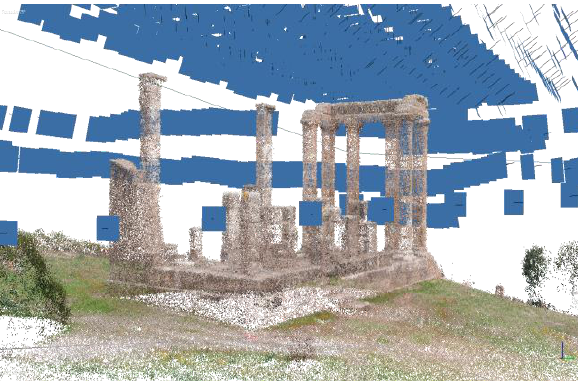
Figure 5. Camera position and sparse cloud